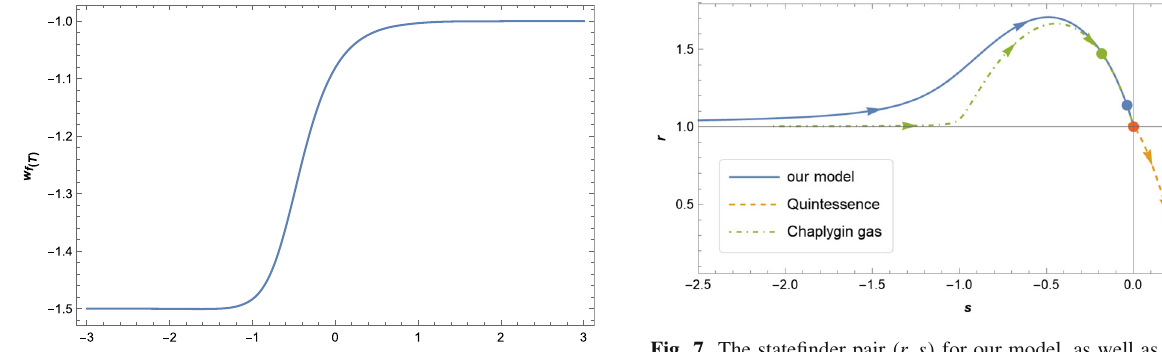
Fig. 7 The statefinder pair ( r , s ) for our model, as well as a specific quintessence model and a Chaplygin gas model described in [76]. The solid rounded points on the lines indicate the present states. The solid rounded point at ( 0 , 1 ) denotes the (cid:2) CDM model